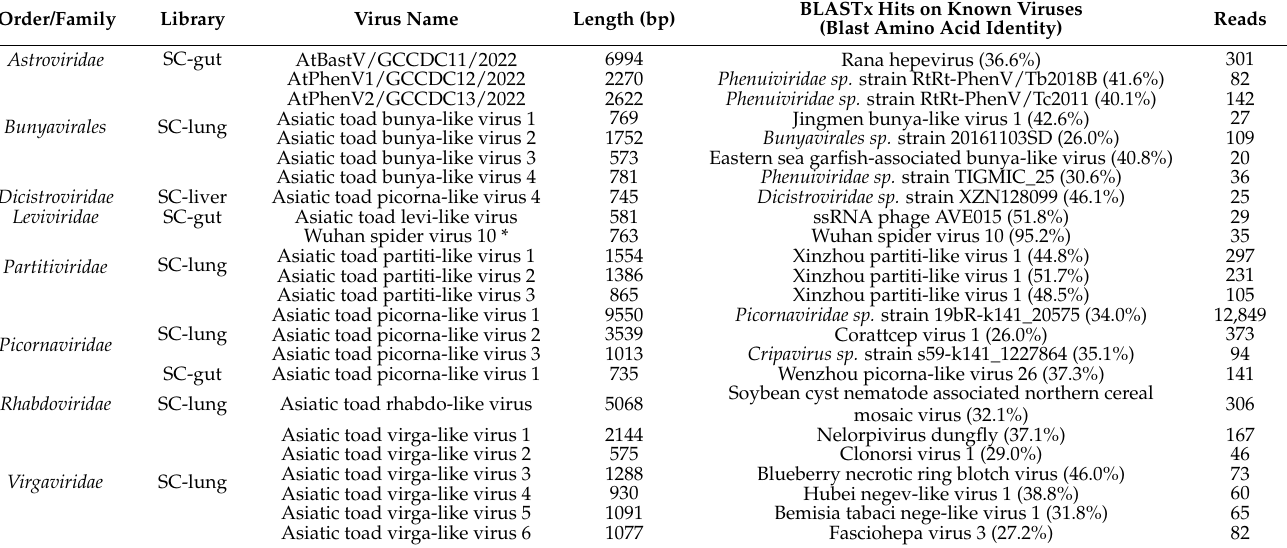
* Previously known